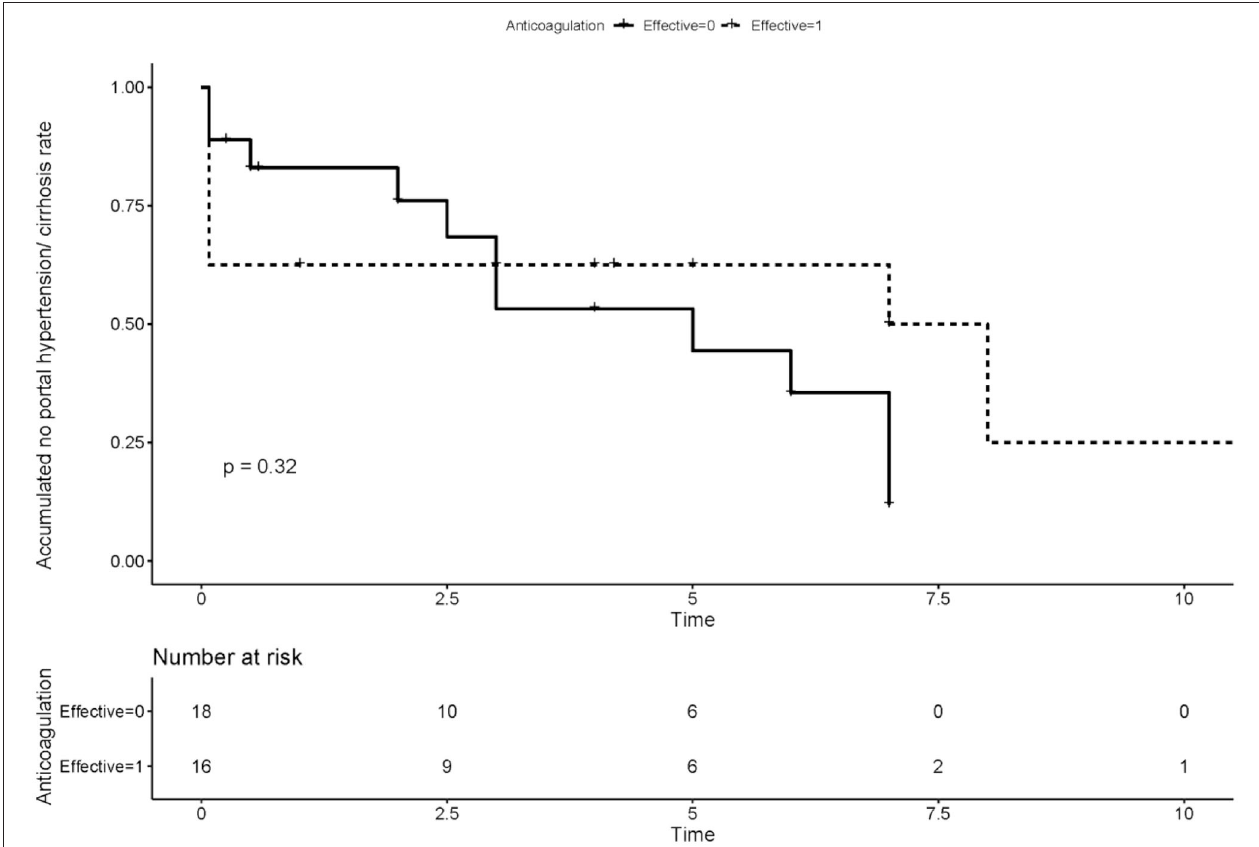
FIGURE 3 | Difference of accumulated no portal hypertension/cirrhosis rate between groups receiving effective anticoagulation ( n = 16) and not ( n = 18). Effective anticoagulation was defined as immediate and sufficient anticoagulant therapy for at least 6 months with a target international normalized ratio (INR) of 2.0–3.0 from the time of portal vein thrombosis (PVT)